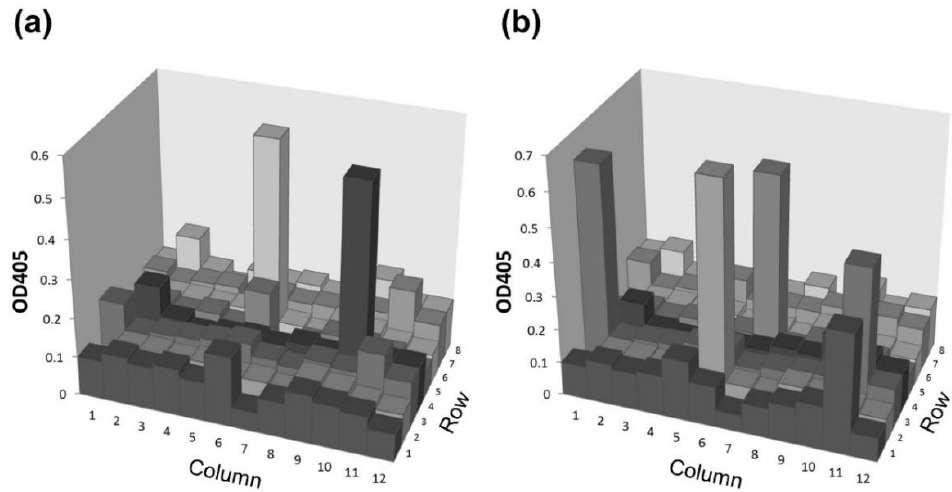
Figure 4. Levels of antigen-specific IgG from hybridomas generated by fusing myelomas with splenocytes from BALB/c mice immunized in vitro with Peptide-1. The supernatants from 96 randomly selected wells from the aforementioned 352 wells were collected, suspended into 96 well ELISA plate (12 columns × 8 rows) and analyzed for antigen binding activity of IgG ( a ) and IgM antibodies ( b ).